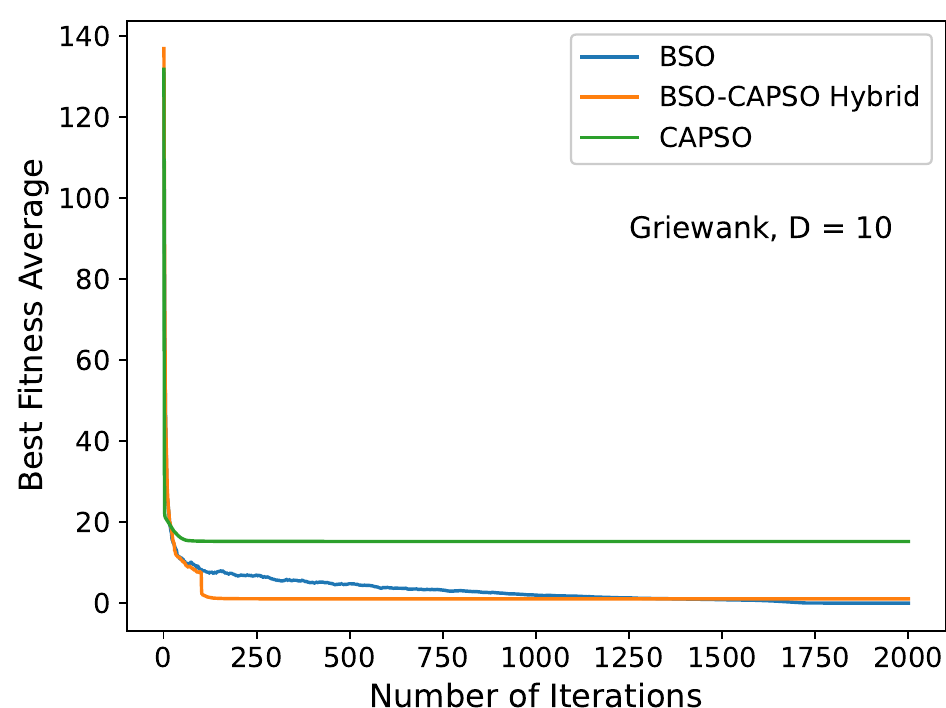
Figure 4. Convergence diagram of the stand-alone BSO, BSO–CAPSO hybrid and CAPSO algorithms for the Griewank ( f 6 ) function with D = 10. Convergence acceleration occurred after t switch = 100.